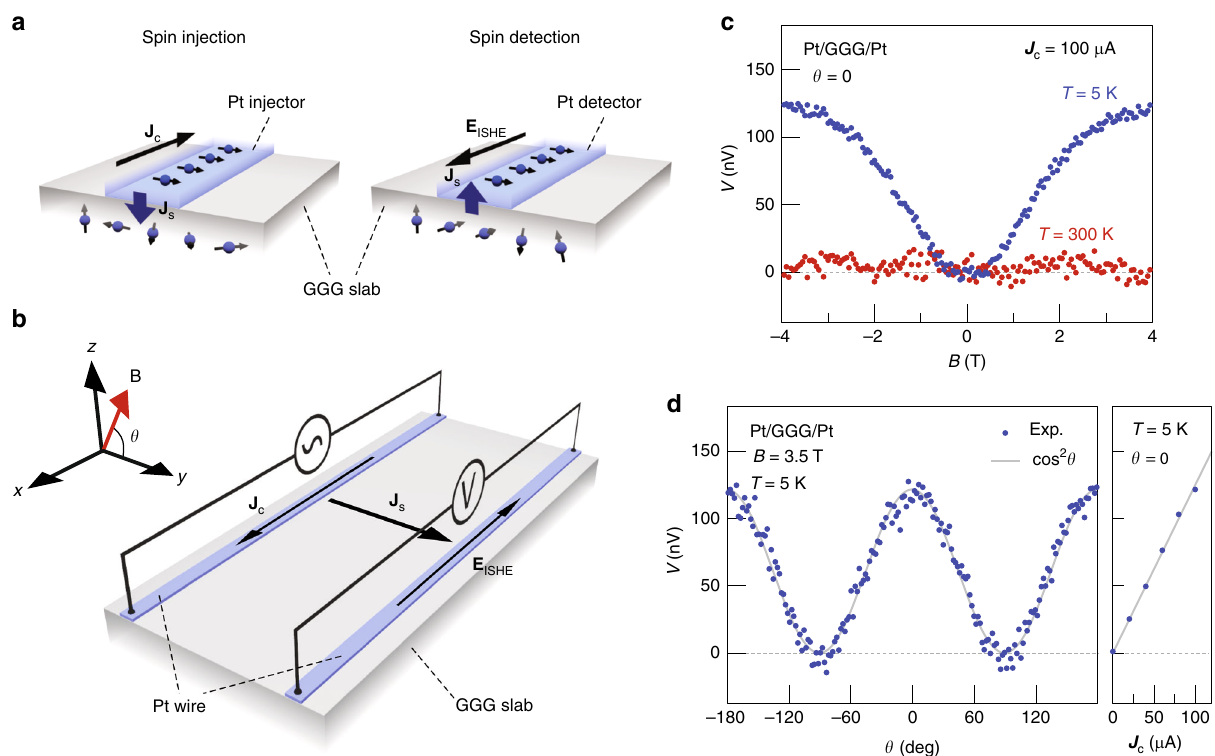
Fig. 2 Observation of long-range spin transport through a paramagnetic insulator. a Schematics of spin injection (left panel) and detection (right panel) at two Pt/GGG contacts. J c and J s denote the spatial directions of charge and spin currents, respectively. J s is injected into GGG by applying J c via the SHE in Pt. At the detector, J s is driven in the direction normal to the interface and is converted into J c via the ISHE in Pt. b A schematic of the experimental setups. The nonlocal device consists of two Pt wires patterned on a GGG slab. B and E ISHE denote the directions of the applied magnetic fi eld and the electric fi eld induced by the ISHE, respectively. We apply J c to the left Pt wire and detect the voltage L | E ISHE | between the ends of the right Pt wire with length L . c The B dependence of V at θ ¼ 0 for Pt contacts separated by d = 0.5 μ m at 300 K (red plots) and 5 K (blue plots) for | B | < 4 T. d The θ and J c dependence of V for the same device at 5 K. The left panel shows the θ dependence of V while B = 3.5 T was rotated in the z – y plane; the gray line is a cos 2 θ fi t. The right panel shows the J c dependence of V max , determined by fi tting V max cos 2 θ to the θ dependence. We subtracted a constant offset voltage V offset from V in c and d (see Supplementary Note